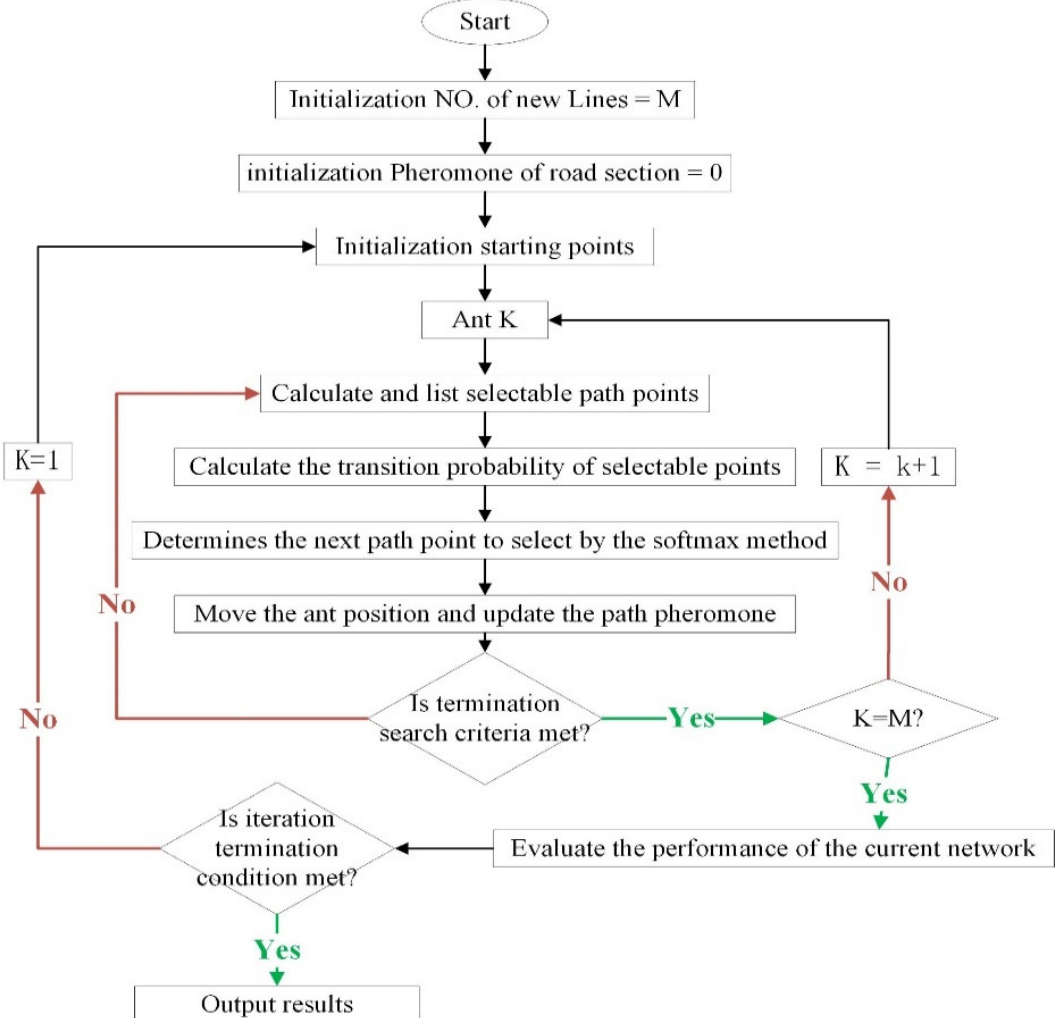
Figure 6. Line network optimization process based on ant colony algorithm.